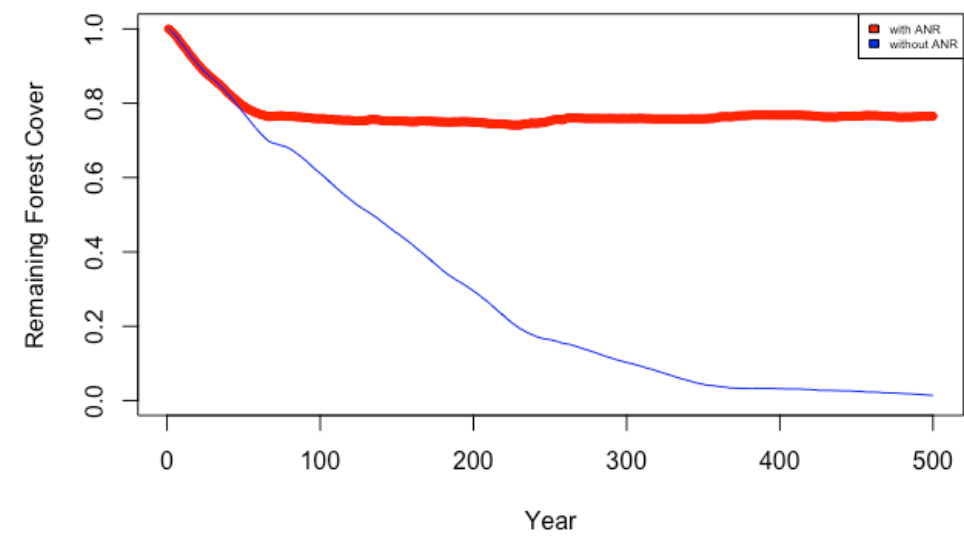
Figure 10. Comparison between the effect of implementing and not implementing ANR in sustaining the forest cover.